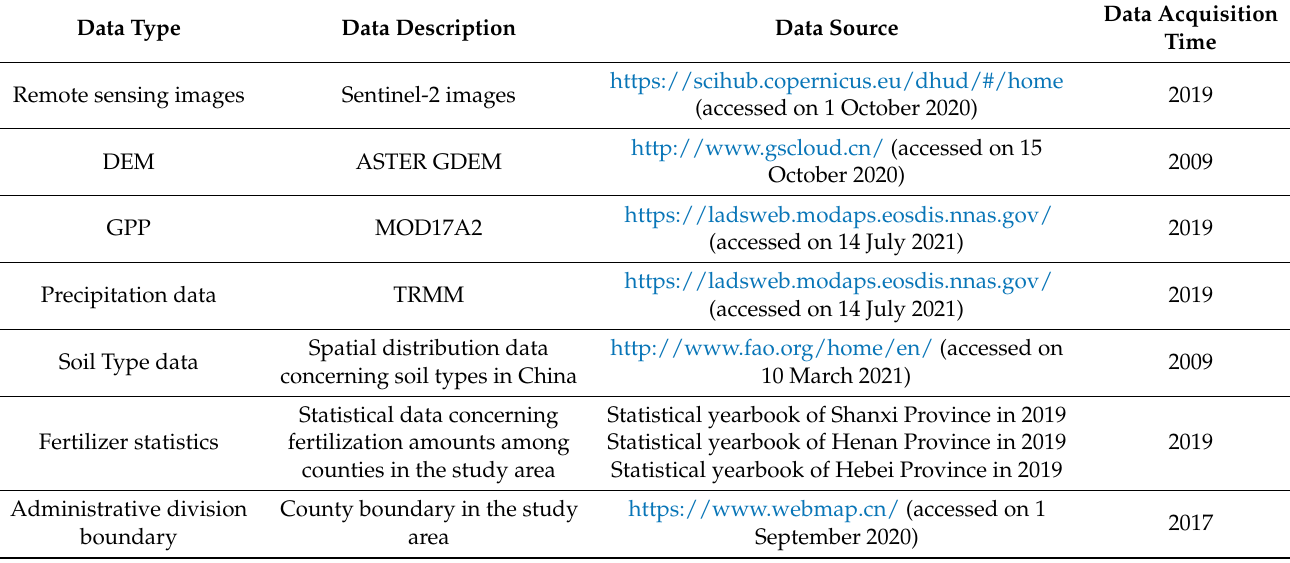
Table 1. Basic data and their